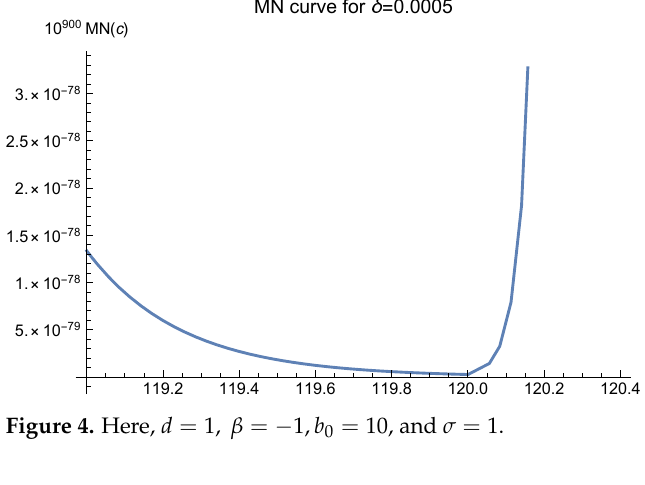
Figure 4. Here, d = 1, β = − 1, b 0 = 10, and σ = 1.